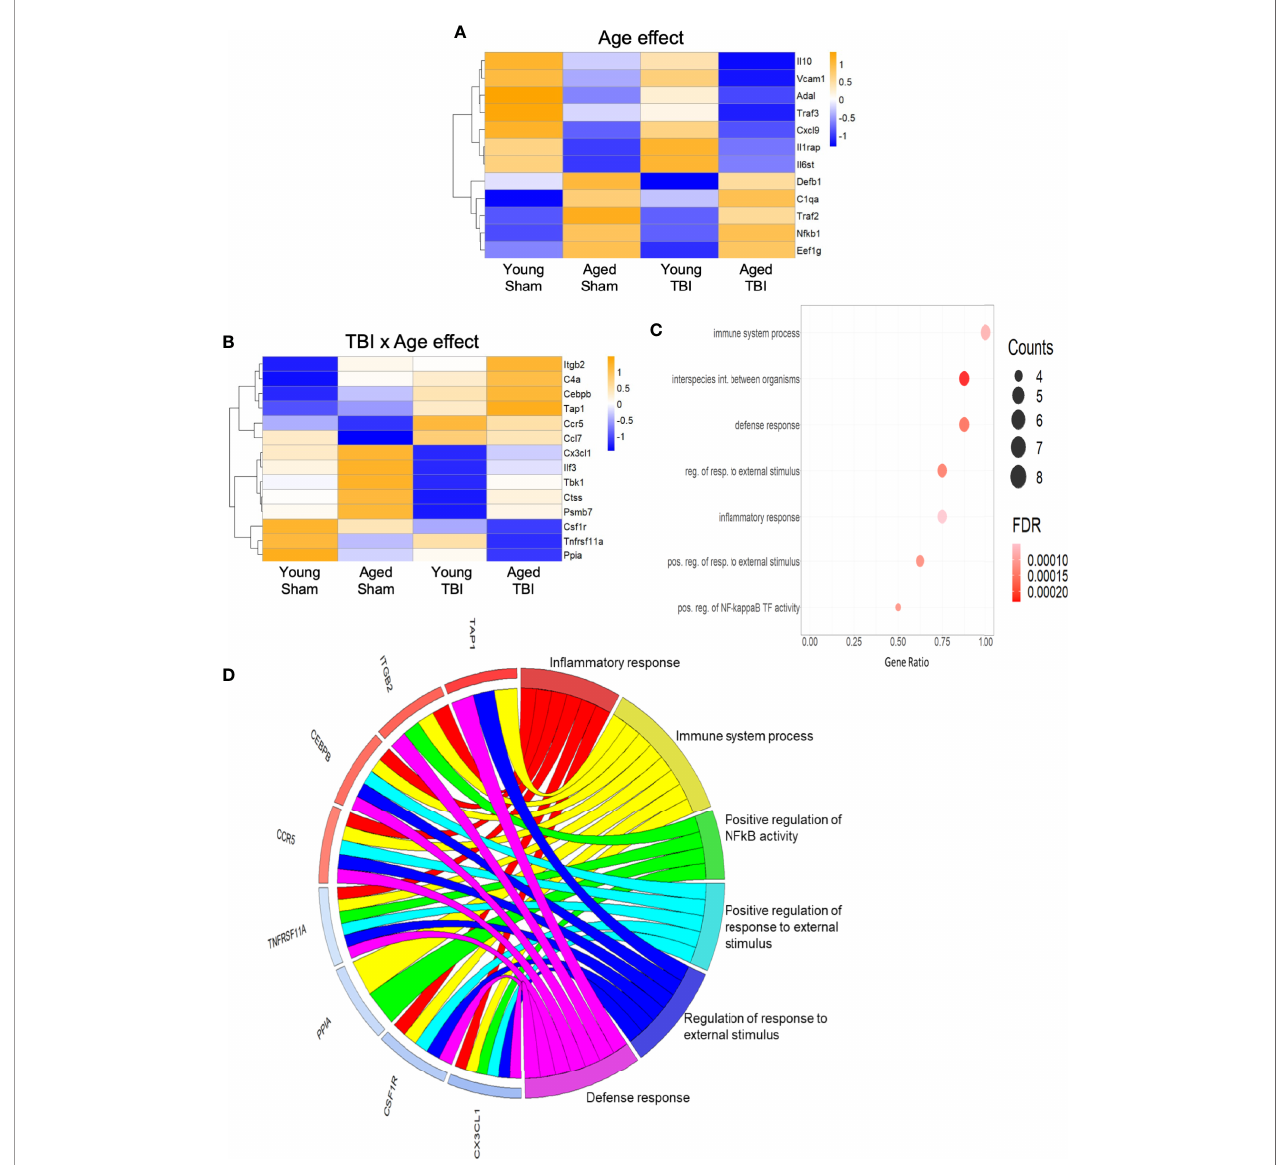
FIGURE 3 | In fl ammatory gene expression in injured cortex is also altered by age alone or combined aged plus TBI. (A) Expression map of transcripts that were signi fi cantly altered by age only. Of these 12, only 4 had R2 values of >0.80 ( Supplemental Table 2 ), indicating that the expression of this group contributed only minimally to the regression model. Biological function GO terms could not be assigned to this group, due to their small number. The heat map color scale re fl ects normalized log-transformed raw counts scaled to z-scores, where -1=darker blue=decreased expression and 1=darker yellow=increased expression. (B) Expression map of transcripts that were signi fi cantly altered by TBI and age (14 genes, 9 with R2 >0.80). The heat map color-scale re fl ects normalized log-transformed raw counts scaled to z-scores, where -1=darker blue=decreased expression and 1=darker yellow=increased expression. (C) Dot plot of biological function GO terms enriched in the group of transcripts that was signi fi cantly altered by TBI and age (R2>0.85). The list of individual genes and their signi fi cance values appears in Supplemental Table 3 . The color of the dots is based on adjusted p-value (FDR) with the darker color (red) corresponding to higher/greater p-value, and lighter color (violet) corresponding to lower/smaller p values. The radius of the dots is based on the number of genes assigned to the term. The x axis corresponds to the gene ratio, which is the ratio of genes within the dataset represented within a given GO term and total number of genes assigned the term. There was no secondary thresholding for injury coef fi cients. The term “ interspecies int. between organisms ” is abbreviated from the full formal name = biological process involved in interspecies interaction between organisms, “ reg. of resp. to external stimulus ” abbreviated from = regulation of response to external stimulus, “ pos. reg. of resp. to external stimulus ” for = positive regulation of response to external stimulus, and “ pos. reg. of NF-kappa B TF activity ” for = positive regulation of NF-kappaB TF activity. (D) CIRCOs plot shows the involvement of genes from (B) with multiple roles in the biological functions de fi ned in (C) . The red and blue bars next to each individual gene indicate increased (red) or decreased (blue) expression of the gene, where intensity of shading indicates the relative change (dark/greater to light/less). Cebpb, Cx3cl1, Ccr5 and Csf1r have a wide range of functions, and were associated with 5 of the 6 GO